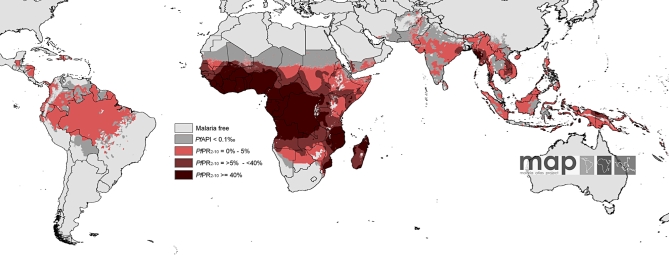
The Spatial Distribution of P. falciparum Malaria PfPR2−10 Predictions Stratified by Endemicity ClassThey are categorized as low risk PfPR2−10 ≤ 5%, light red; intermediate risk PfPR2−10 > 5% to < 40%, medium red; and high risk PfPR2−10 ≥ 40%, dark red. The map shows the class to which PfPR2−10 has the highest predicted probability of membership. The rest of the land area was defined as unstable risk (medium grey areas, where PfAPI < 0.1 per 1,000 pa) or no risk (light grey) [17–19].